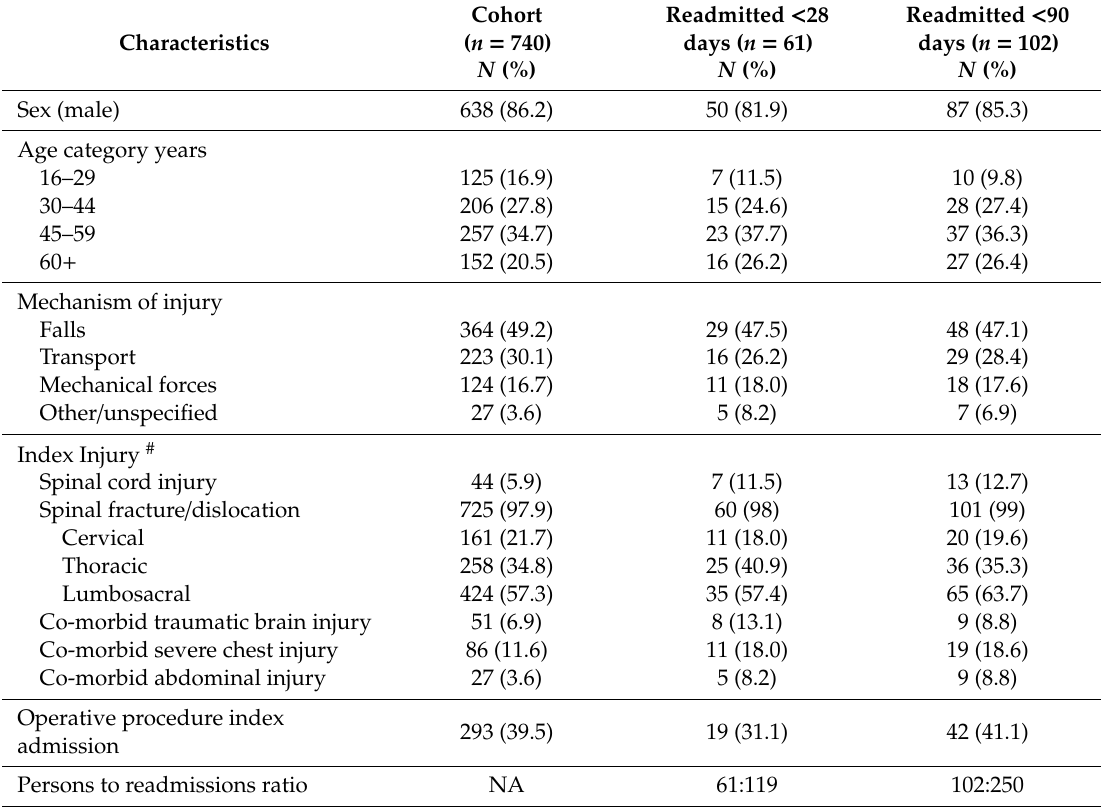
Table 1. Characteristics of the injured cohort compared with readmitted